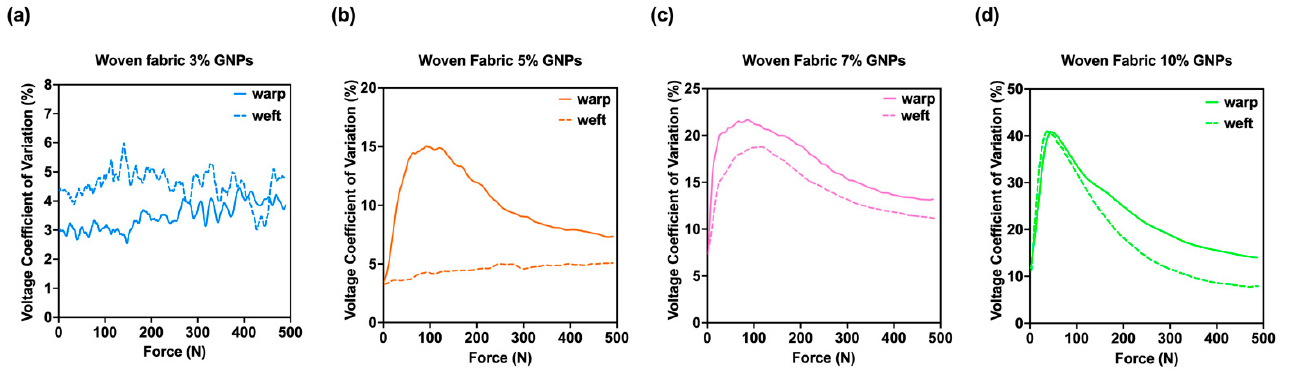
Figure 17. Voltage Coefficient of Variation (CV%) for ( a ) woven fabric doped with 3% GNPs, whose active material was assembled towards the walewise (continuous line) and towards the coursewise directions (dotted line); ( b ) woven fabric doped with 5% GNPs, whose active material was assem- bled towards the walewise (continuous line) and towards the coursewise directions (dotted line); ( c ) woven fabric doped with 7% GNPs, whose active material was assembled towards the walewise (continuous line) and towards the coursewise directions (dotted line); ( d ) woven fabric doped with 10% GNPs, whose active material was assembled towards the walewise (continuous line) and towards the coursewise directions (dotted line).